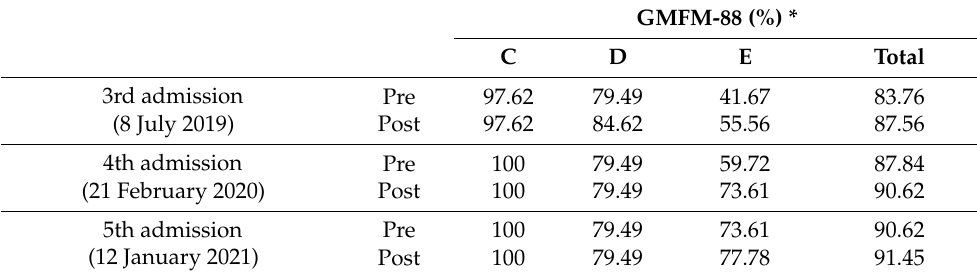
Table 1. Changes in GMFM during the 3rd to 5th admissions for case